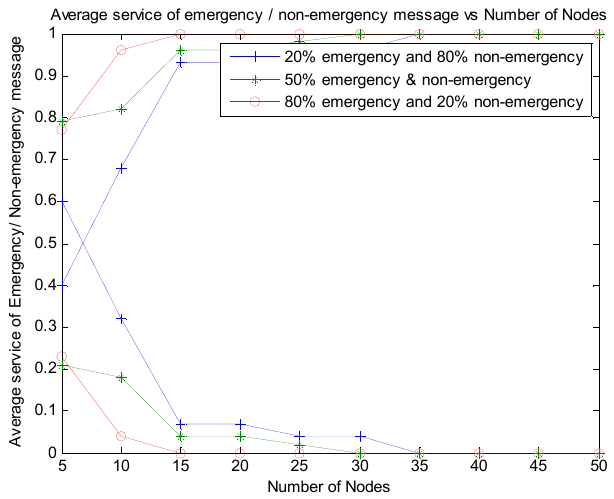
Figure 17. Average service of emergency message vs. number of nodes.